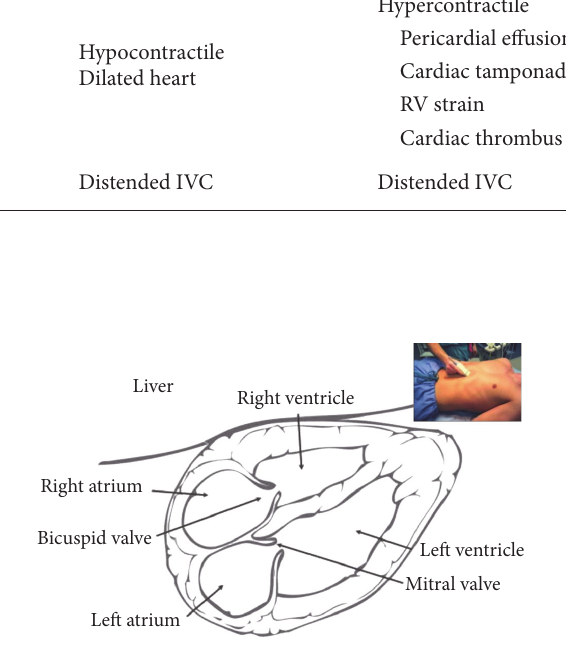
Figure 2: Subcostal cardiac landmarks. Subcostal view is a good window for locating the right atrium prior to the IVC, is useful for qualitative assessment of cardiac contractility, and is sensitive for detecting pericardial effusion or tamponade (frequently unsus- pected). As in all transthoracic cardiac views, the right ventricle is closest to the ultrasound probe (see Figure 1, probe posi- tion A1). Reproduced from http://www.sonoguide.com/FAST.html